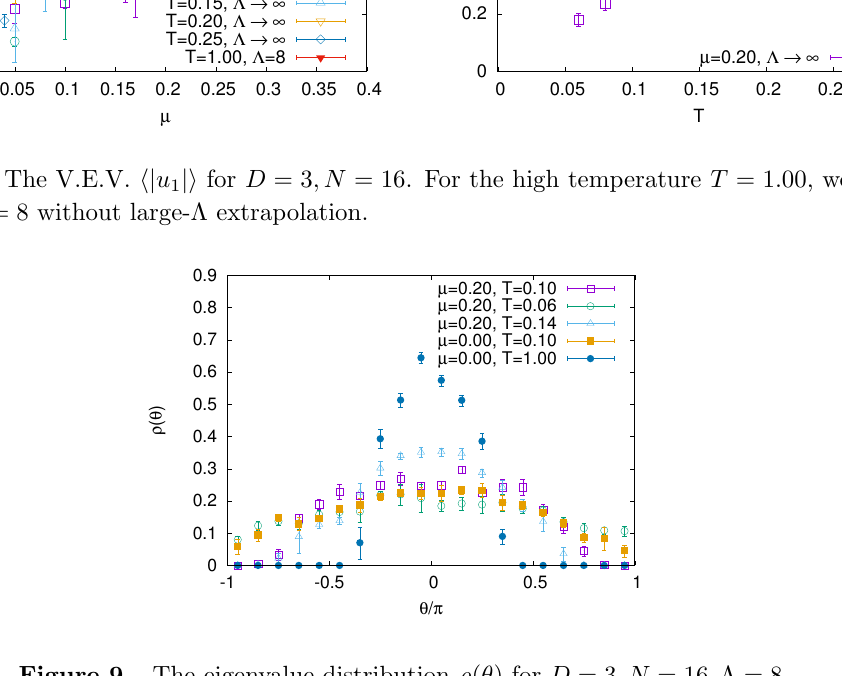
Figure 9 . The eigenvalue distribution (cid:26) ( (cid:18) ) for D = 3 ; N = 16 ; (cid:3) =